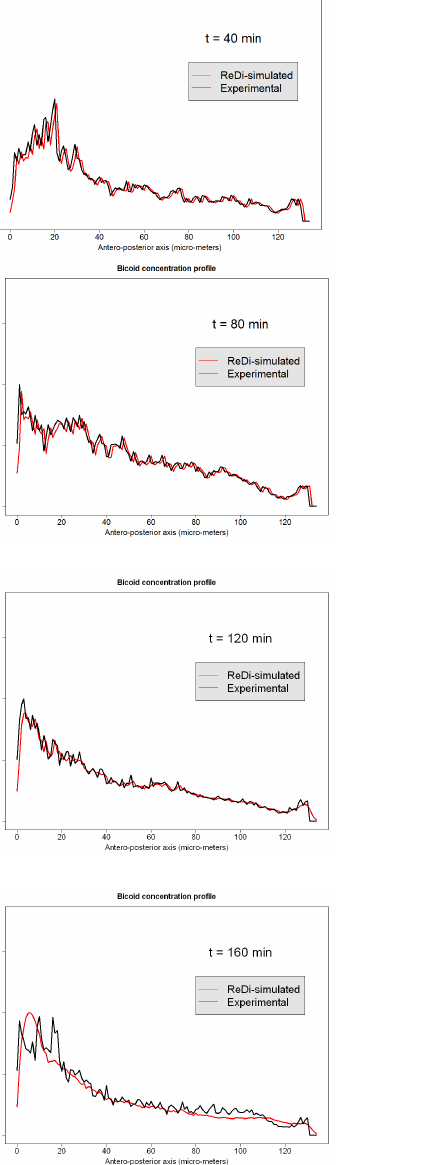
Figure 8: Average Bicoid protein fluorescence profiles along the antero-posterior axis at different instants of time. The black curve is the experimental profile and the red is the curve obtained from the Redi simulation. Simulations are in good agreement with the experimental observations. Dis- crepancies are visible mostly as a slight shift of the simulated curve with respect to the measured one in the first minutes of the simulation and within a distance of 20 µ m from the anterior pole of the egg. In this region the experimental video is noisy and, consequently, the first approximation of the derivative of the concentration in Eq. (9) is not accurate